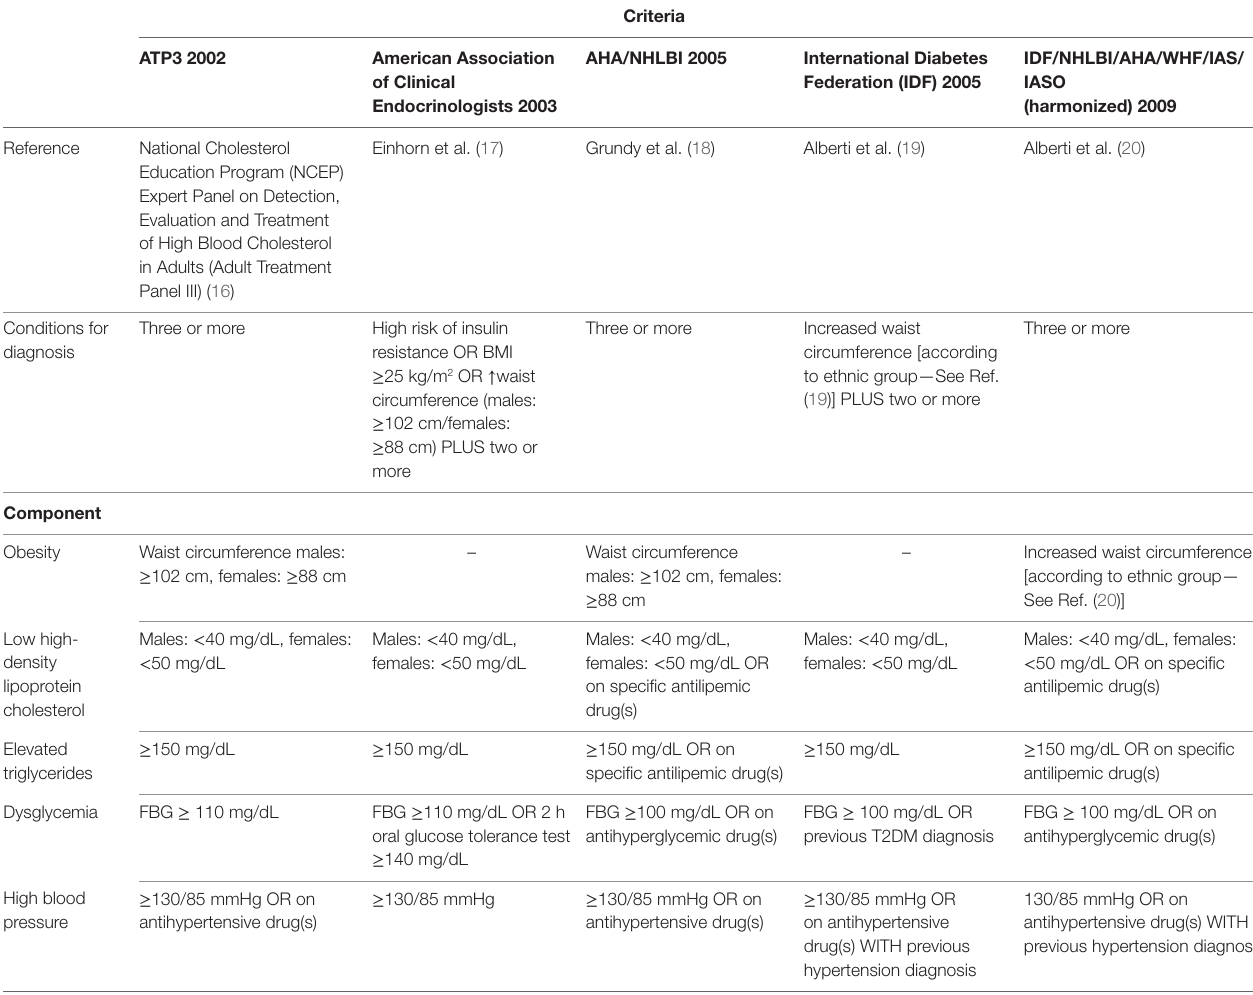
TaBle 2 | Comparative view of components of five accepted criteria for metabolic syndrome diagnosis.